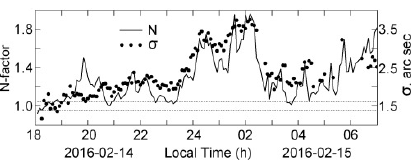
Fig. 4. Temporal variations of the amplification factor N at a distance of 1900 m (solid curve) and rms deviation of random image jitter  (circles). Local time. Data of February 14-15 of 2016.